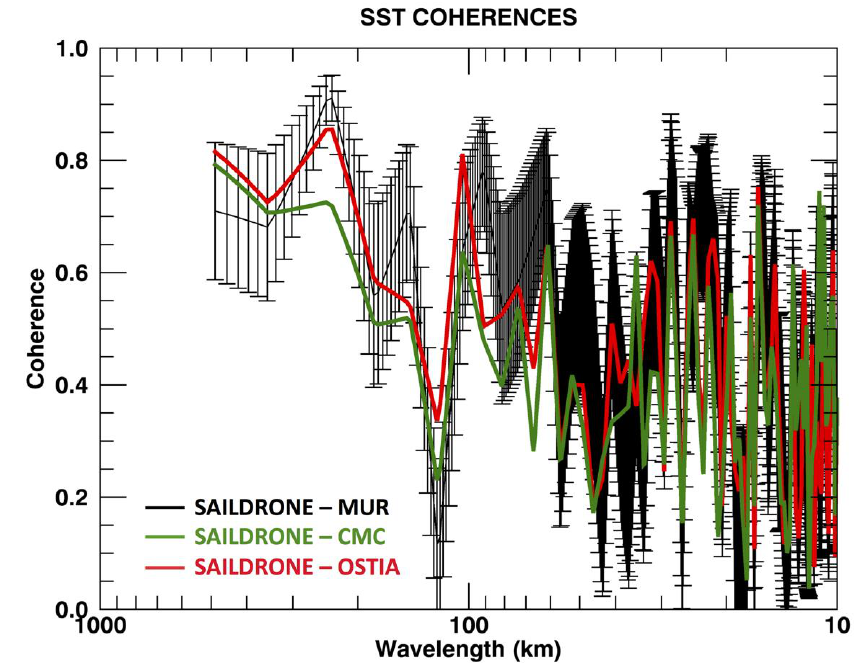
Figure 9. Coherences between the Saildrone SST and the SST from the MUR, OSTIA, and CMC products.